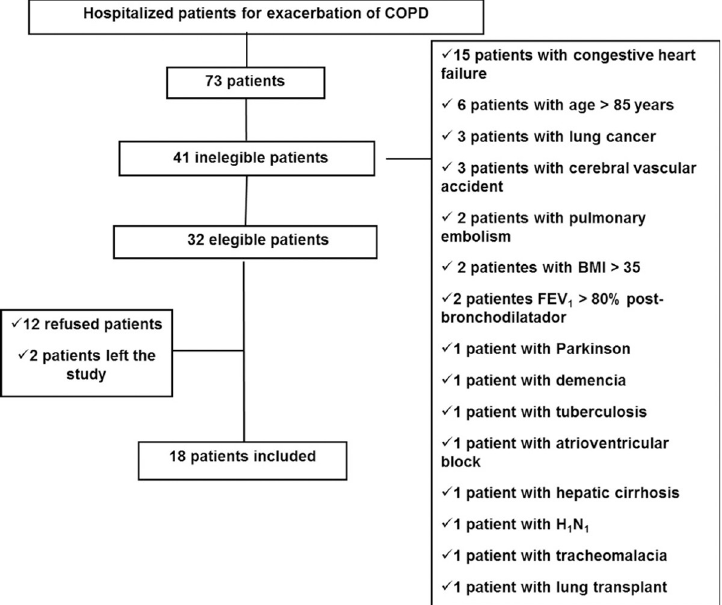
Fig 2. Screening flow chart. Abbreviations: AECOPD, acute exacerbation of chronic obstructive pulmonary disease.